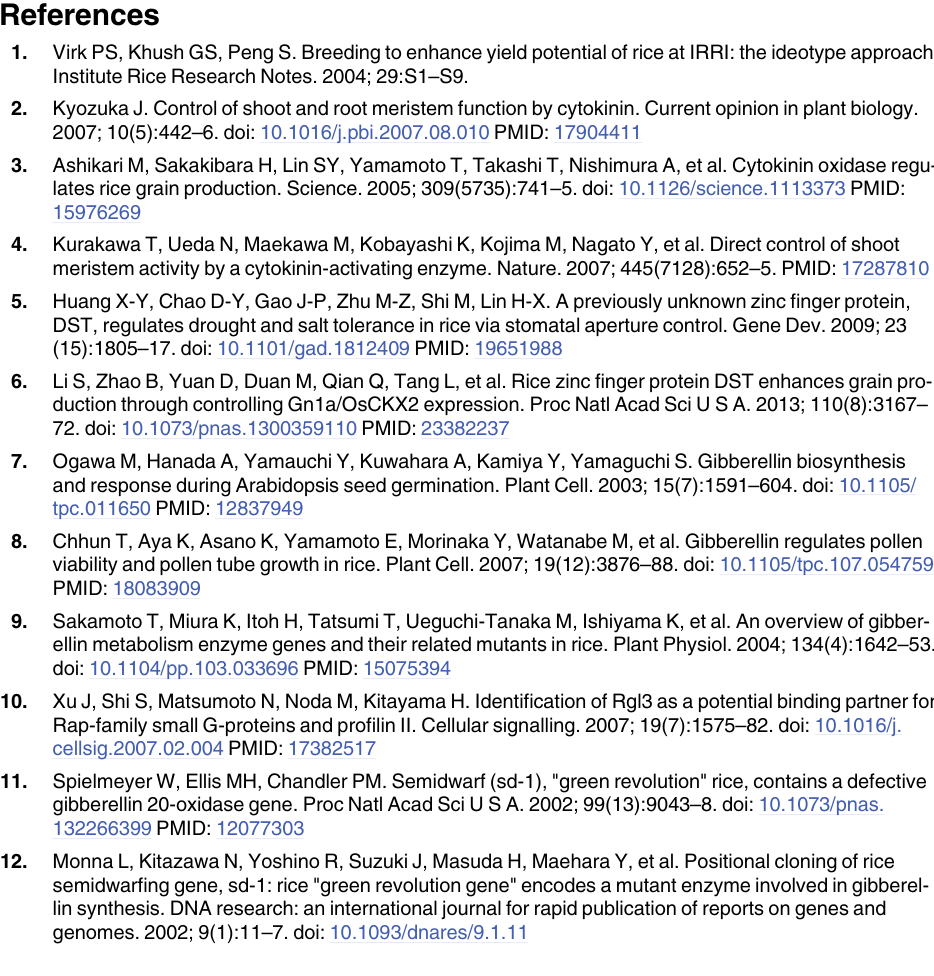
S8 Table. Oligo sequencesused for in situ